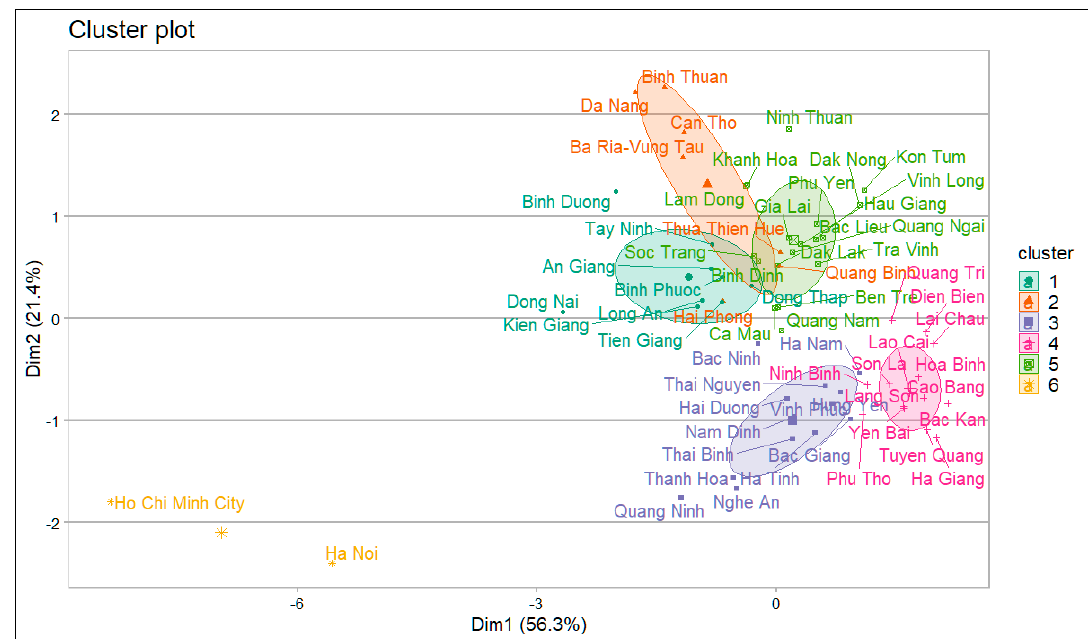
Figure 12. The results of clustering provinces based on their potentials and characteristics. The results do not only recommend policy priority but also support national policymakers to redirect and balance the PV development between different regions. For example, the government